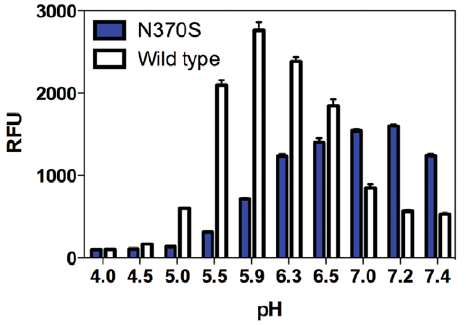
Figure 1. pH profiles of recombinant N370S and WT GCase. The assay was performed in the presence of 10 mM NaTC. While the